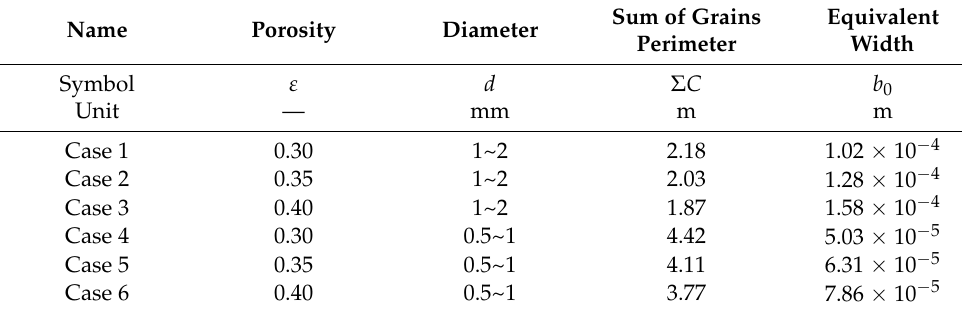
Figure 9. Comparison between the estimated value and the numerical value of injection pressure. The solid line represents the numerical results, and the dashed line represents the estimation results with the proposed formula. ( a ) grain size 1~2 mm; ( b ) grain size 0.5~1 mm. Table 2. Estimation on the equivalent